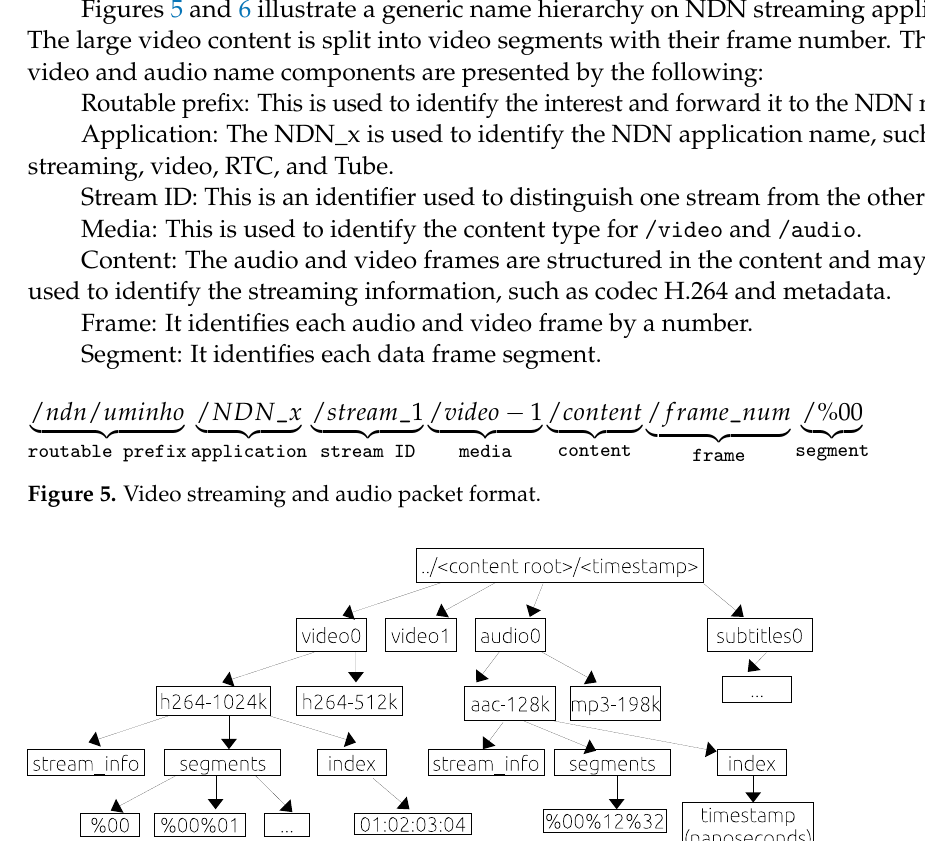
Figure 6. NDN streaming applications namespace (Adapted from